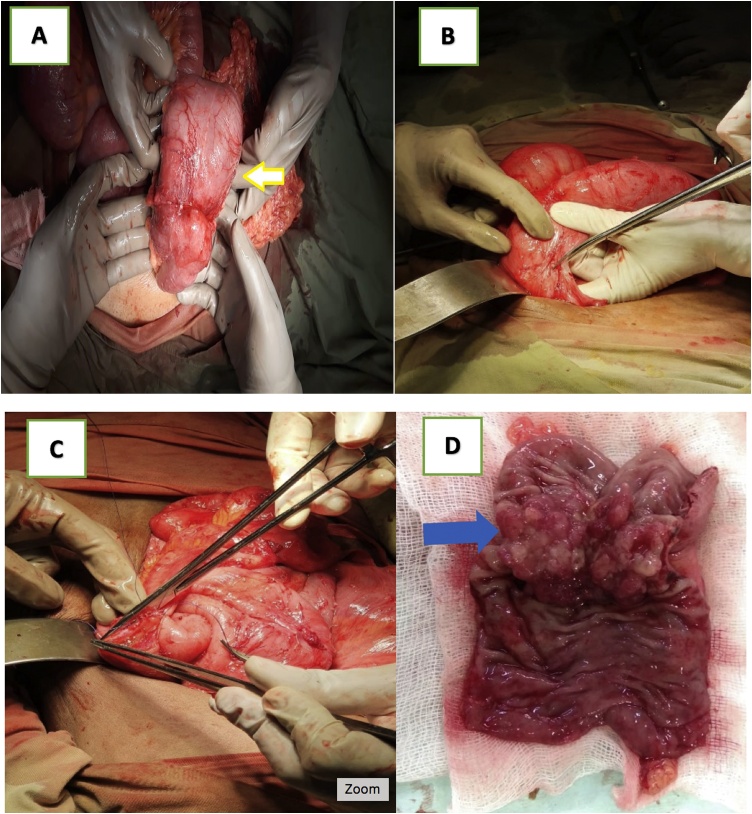
Intraoperative findings: A) showing the descending colon mass (yellow arrow); B) and C) left hemicolectomy with end-to-end anastomosis; D) gross photomicrograph of left hemicolectomy specimen showing a large ulcerated mass/growth around 7 × 6 × 5 cm infiltrating the serosa (blue arrow).